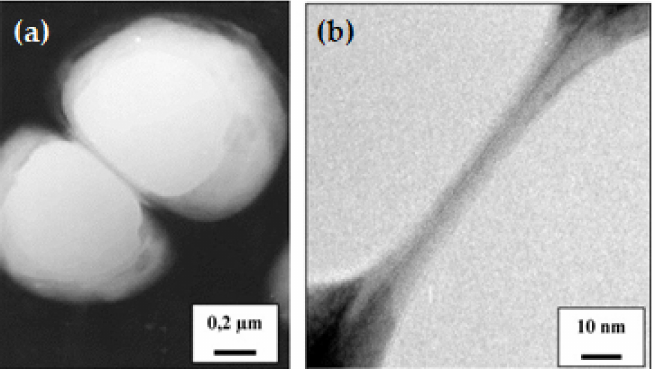
Figure 2. TEM observations of adjacent NCPs: ( a ) medium-sized magnification image; ( b ) high magnification image of the area of contact between the two NC. The membrane thickness of NC is estimated to be 1–2 nm. Adapted with permission from ref. [52]. 2021,